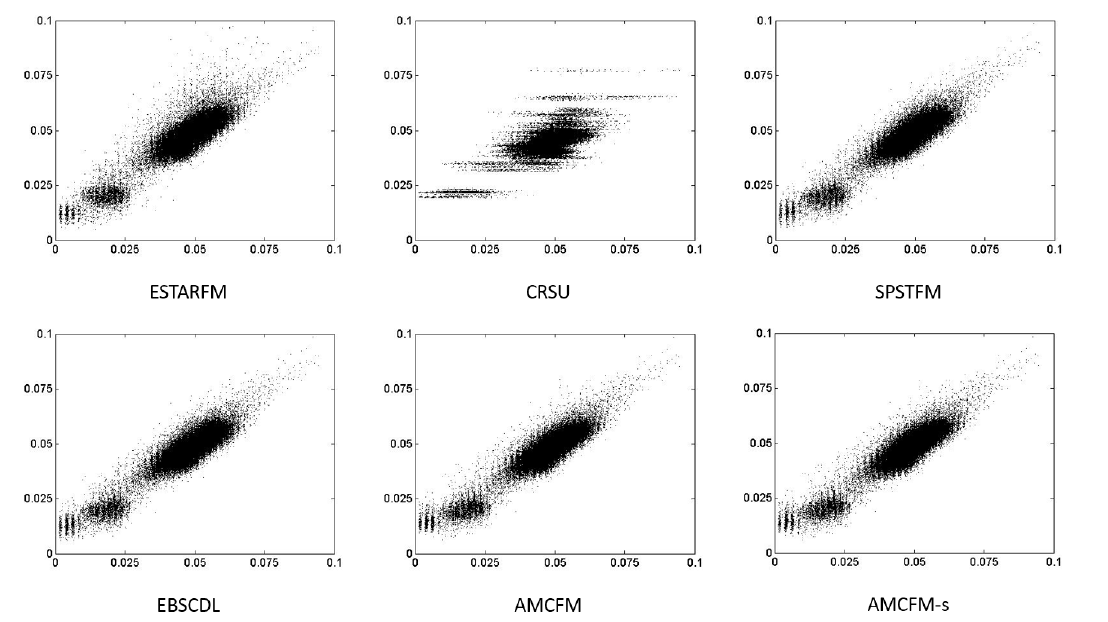
Figure 6. Scatter plots of green band of image 1. Abscissa is the true reflectance and ordinate is the predicted reflectance.